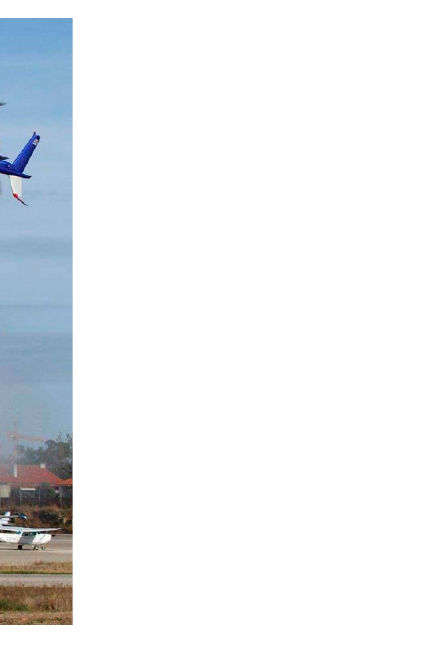
Figure 17. AS350B2 firefighting tank used for water dump firefighting (found online at